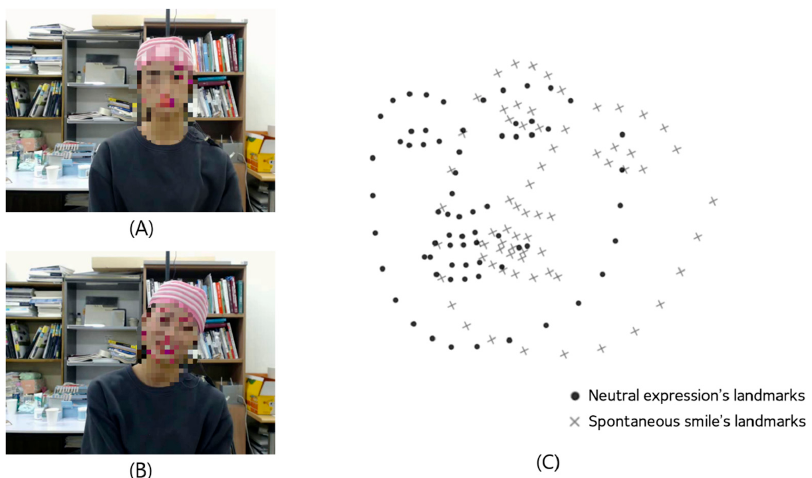
Figure 3. The example of alignment problem between facial landmarks in neutral and smile expression: ( A ) head position and angle during neutral expression, ( B ) head position and angle during smile expression, ( C ) example of misalignment problem between two facial landmarks.